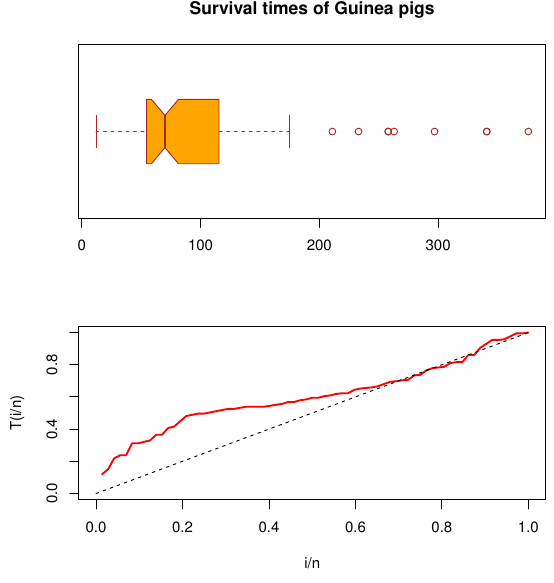
Figure 4. Box plot and TTT plot for the survival times of guinea